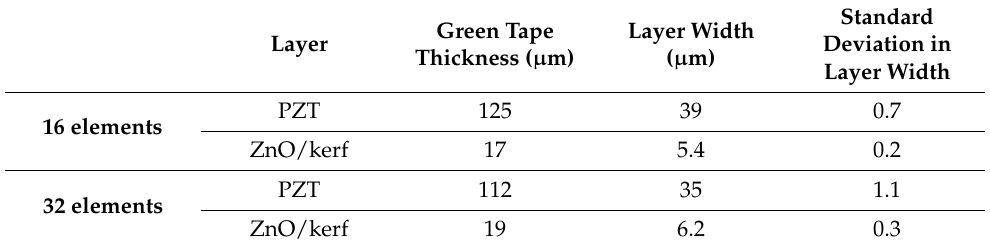
Table 3. PZT and ZnO width measurements for the 2-2 composites containing 16 and 32 PZT beams. Green Layer